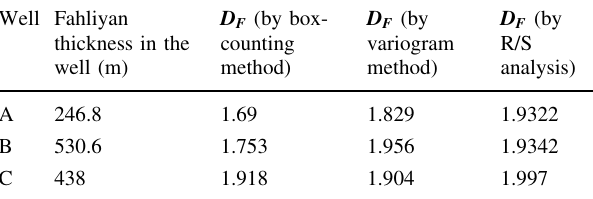
Table 9 Determination of fractal dimension ð D F ) in well C for core